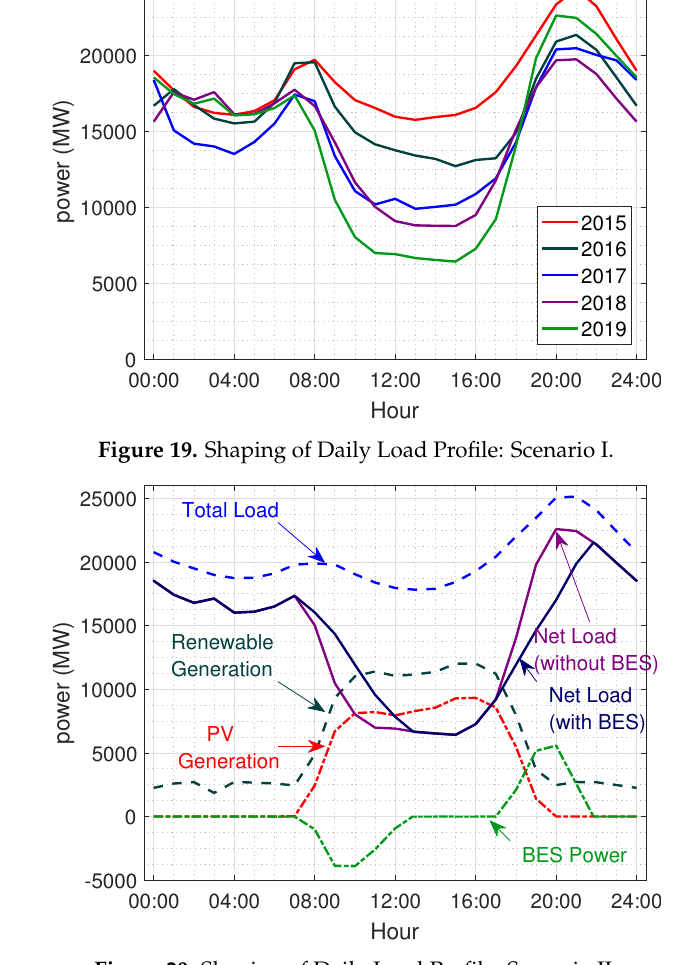
Figure 20. Shaping of Daily Load Profile: Scenario